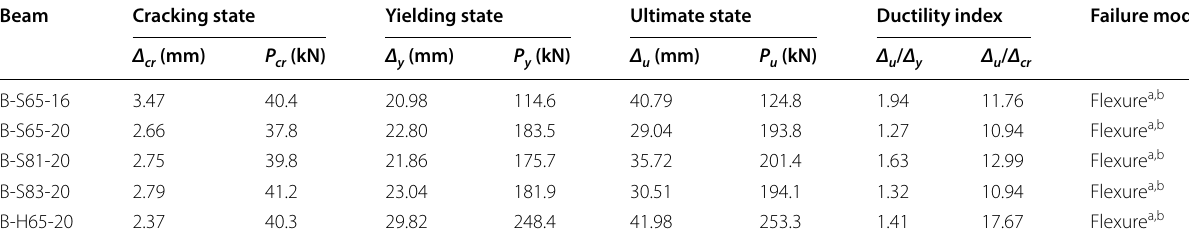
first cracking load, Δ y = ultimate load. =